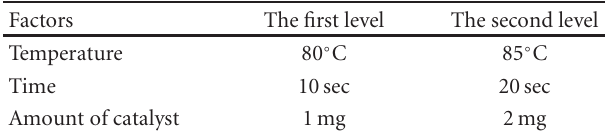
Table 2: Based on the L 4 (2 3 ), 4 combinations are selected form 8 combinations for experiments.